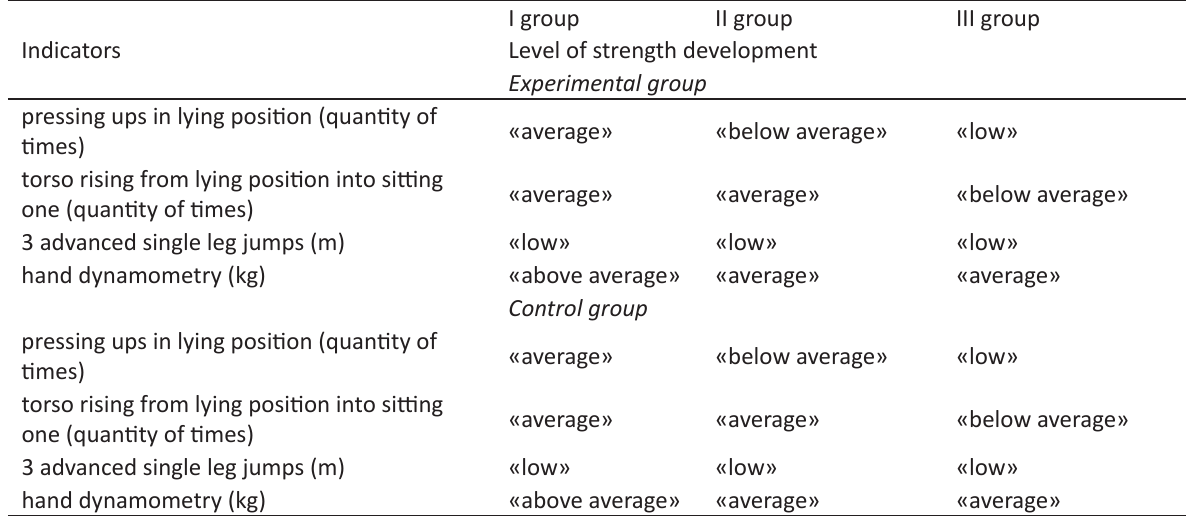
Table 2. Estimation of the strength development level of girl-students before the experiment